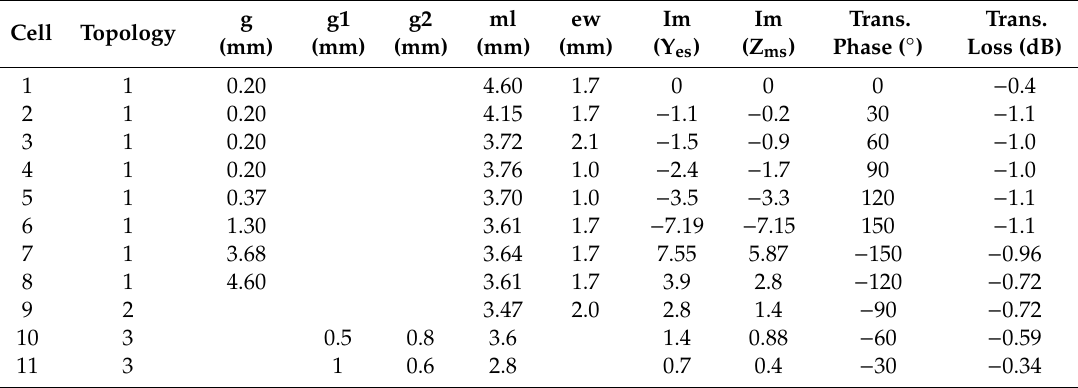
Table 1. Geometric parameters, simulated electric surface admittance (Y es ), magnetic surface impedance (Z ms ), transmission phases, and transmission loss of the 11 metasurface unit cells with topologies 1, 2, or 3.